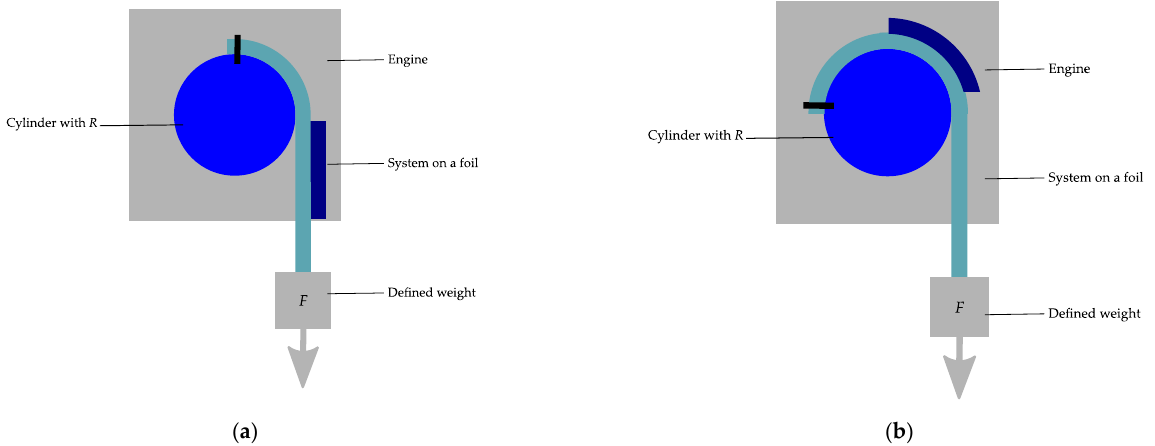
Figure 16. Illustration of a roll to flex bending machine with attached sample; ( a ) in a flat and ( b ) in a bent position. Modified and freely sketched after [94].